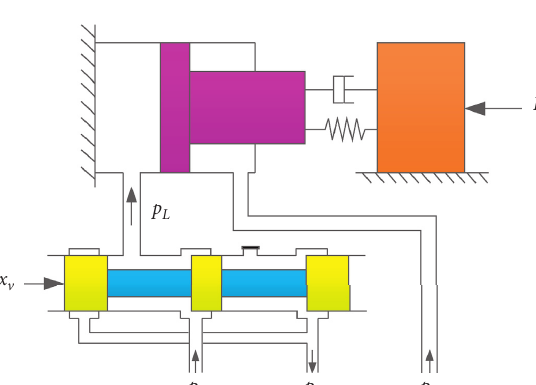
Figure 3: Principle of hydraulic cylinder controlled by servo